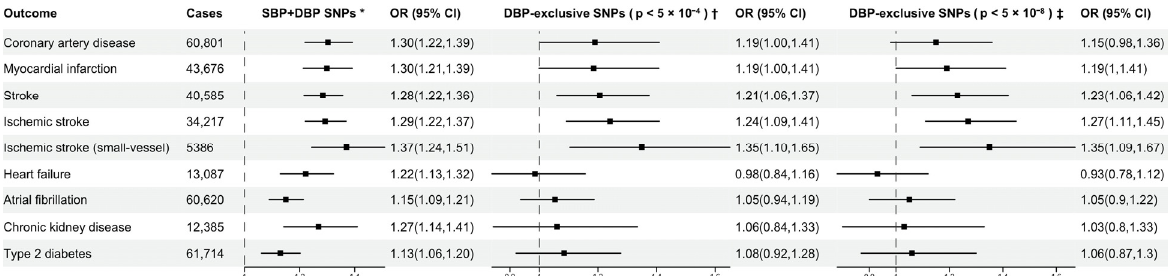
Figure 3. Mendelian randomization estimates (odds ratio with 95% CI per 5 mmHg increase in genetically predicted diastolic blood pressure) from the inverse variance weighted method. SNP indicates single nucleotide polymorphism; OR, odd ratios; SBP, systolic blood pressure; DBP, diastolic blood pressure. * 242 SNPs associated with both SBP and DBP ( p < 5 × 10 − 4 ), identified in a BP GWAS meta-analysis study [17]. † 80 SNPs associated with DBP ( p < 5 × 10 − 4 ) but not associated with SBP. ‡ 54 SNPs associated with DBP ( p < 5 × 10 − 8 ) but not with SBP ( p > 5 × 10 − 4 ).